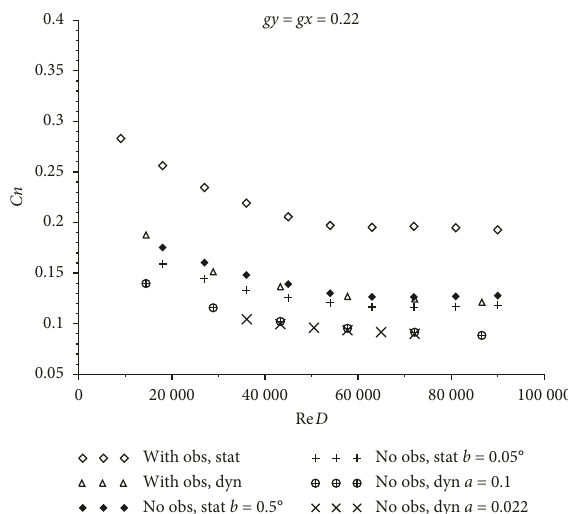
Figure 17: Evolution of Cn as a function of Re D , comparison between steady and dynamic simulations.